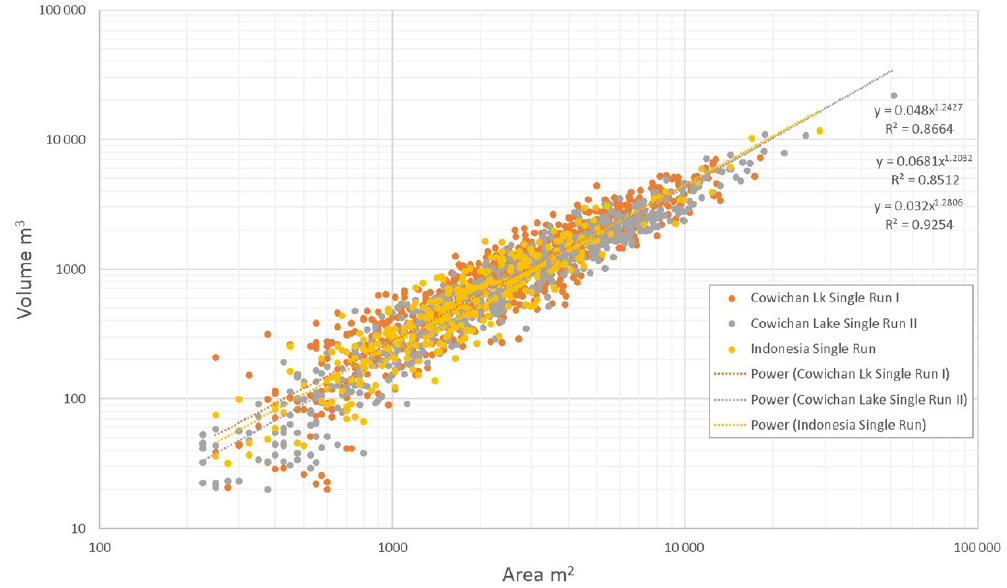
Figure 5. Landslide area–volume relationships for modeled single-run landslides in Indonesia and from Vancouver Island. Data come from case studies described in subsequent sections. Table 2. Areas and volumes from this study compared with historical studies of debris flow area–volume